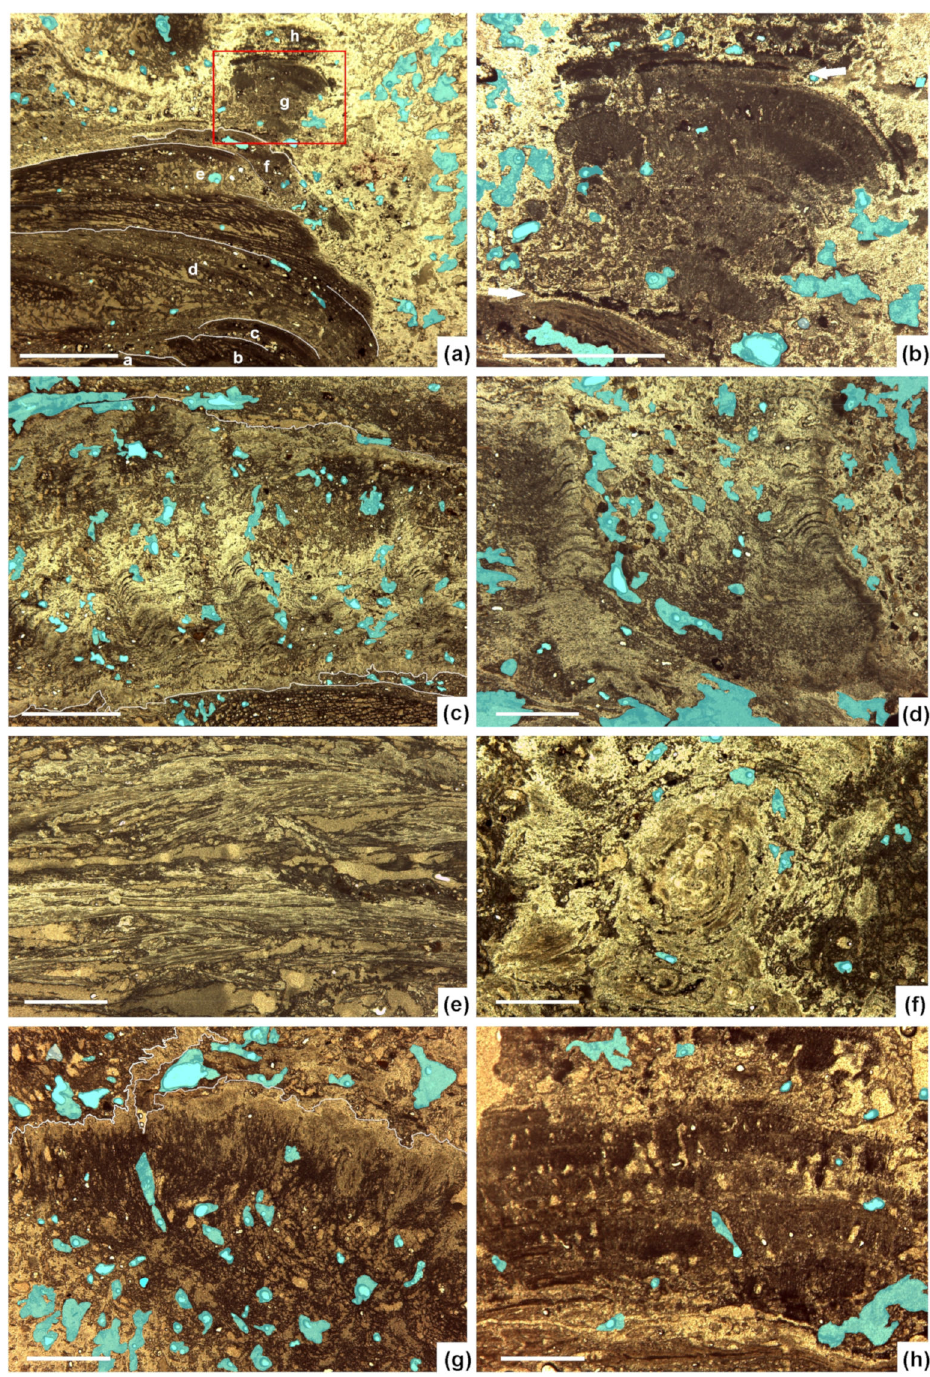
Figure 4. Representative optical photomicrographs from the petrographic study of the Selt ú n sinter exhibiting two- dimensional (2D) textures in transmitted plane light. ( a ) Superposition of microbial packages ( a to h ) showing onlapping features; lower packages show repeated upward decreases in laminoid-to-subelliptical porosity; microbial lamination are not subparallel, but display a superposition of convex-up sublaminae. ( b ) Detail of boxed area in previous picture (package labelled g ), with palisade laminated fabric bounded by sharp (arrowed) contacts. ( c , d ) Pseudo-columnar (pencil-like) microstromatolitic laminae up to 5 mm high and 1.8 mm in basal diameter. ( e ) Microbial laminae adapting to laminoid pores and exhibiting crinkled features. ( f ) Microbial oncoid up to 2 mm across. ( g ) Bunch of microbial laminae subtransverse to stratification. ( h ) Superposition of palisade laminae, each one up to 400 µ m thick; larger pores artificially stained in blue; scale bars = 2 mm (for Figure 4a,c) and 1 mm (for Figure